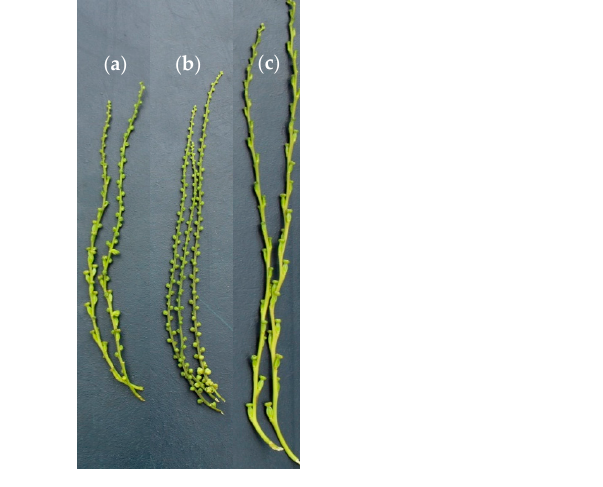
Figure 3. Monoecious plant of Dioscorea rotundata showing both pistillate and staminate flowers. Table 1. Flowering intensity and flower sex distribution among genotypes of Dioscorea species. Number of Observed Genotypes